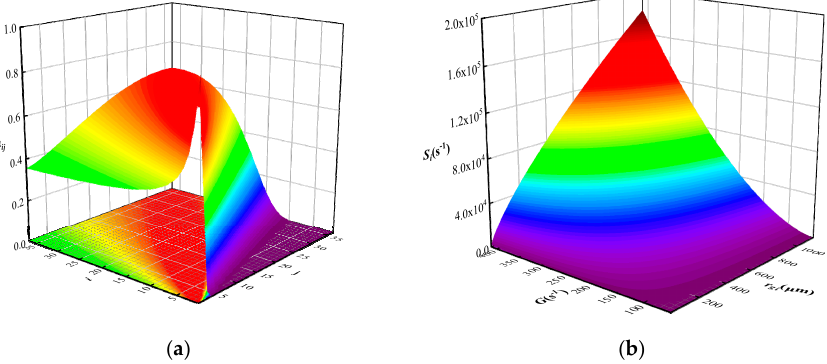
Figure 6. Breakage rate coefficient in PBM of ( a ) run 16; ( b ) run 20. The x-axis and y-axis represent r , respectively. The z-axis denotes the breakage rate coef- the shear rate G and gyration radius gi ficient i S .